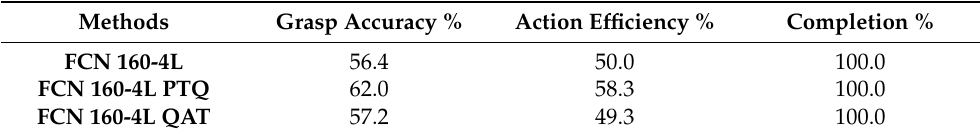
Table 3. Results for real robot setup tested on toy blocks challenging scenarios. Optimized 160-4L architecture is considered. Both Post-Training Quantization (PTQ) and Quantized-Aware Training (QAT) are explored.